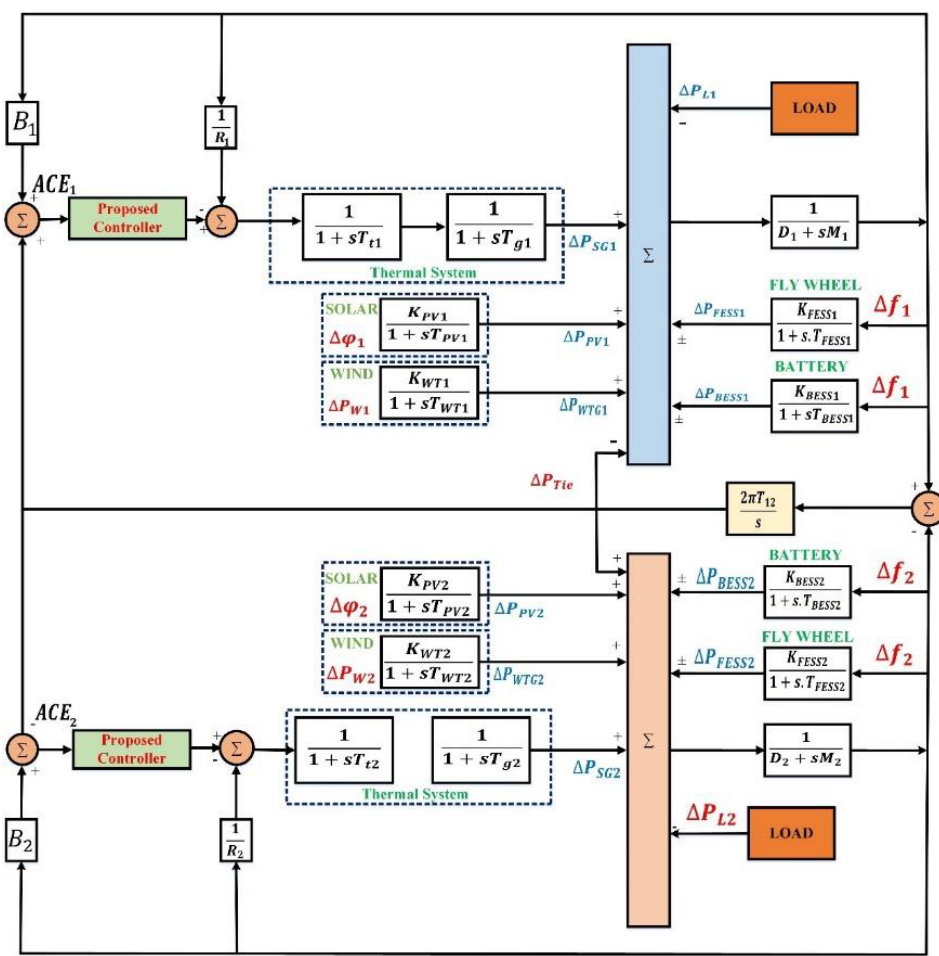
Figure 2. Model under